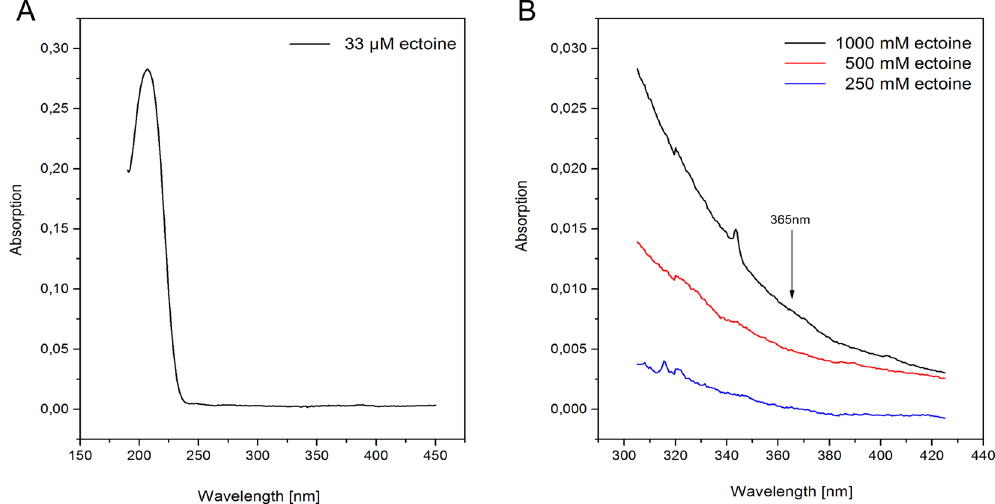
Figure 4. UV-absorption of ectoine in water. Absorption spectra of 33 µ M ectoine ( A ) in the range of 190– 450 nm and ( B ) at higher concentrations of ectoine (1000 mM, 500 mM, 250 mM) in the range of 305–425